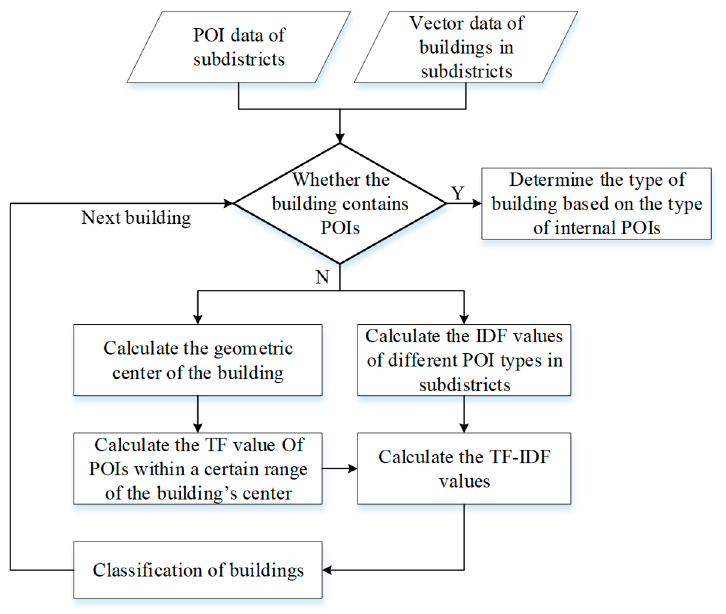
Figure 2. Building classification process.